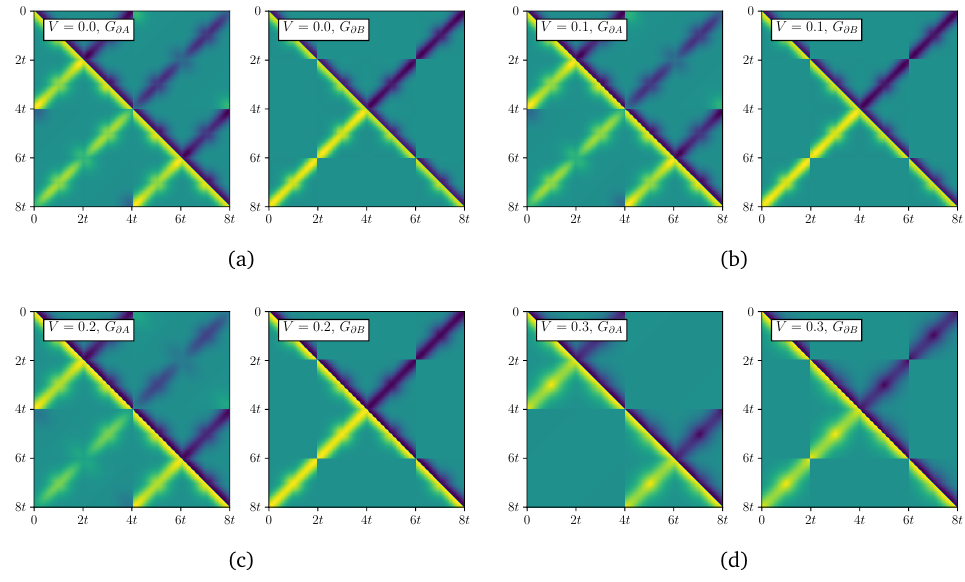
Figure 6: Green’s function profile on the subsystem boundary ∂ A and ∂ B for various V at t = 8. Initial condition Type 2(QA) is applied. As V increases, the saddle point solution gradually changes from a replica quasi-diagonal solution to a replica diagonal